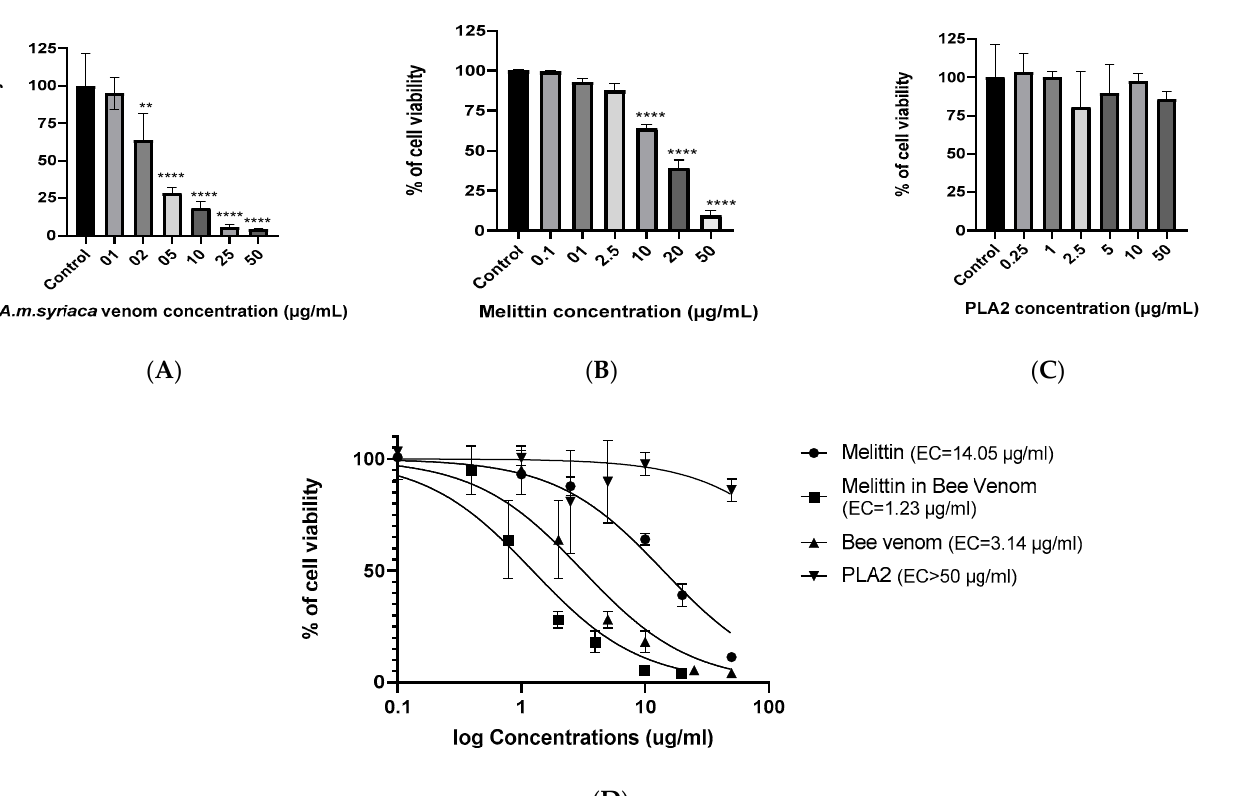
Figure 2. Cell viability of HCT116 colon cancer cells was measured by MTT assay after treatment with increased concentrations of ( A ) A. mellifera syriaca venom, ( B ) standard melittin (MEL), and ( C ) standard PLA2. The results represent the mean ± SD of three independent experiments. Statistically significant compared with untreated cells ** p < 0.01, and **** p < 0.0001. ( D ) Curves for MTT assay showing EC50 values and the % of cell viability in function of log concentrations of standard MEL, MEL in A. mellifera venom (titration curve), A. mellifera venom (from A. mellifera syriaca bees), and standard PLA2. The results represent the mean ±SD of three independent experiments.